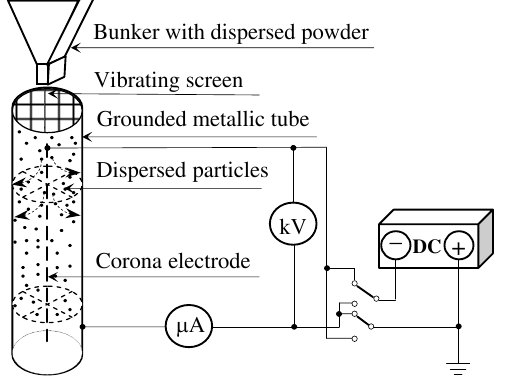
Fig 2. Installation for dispersed materials activation in the corona-electrostatic field